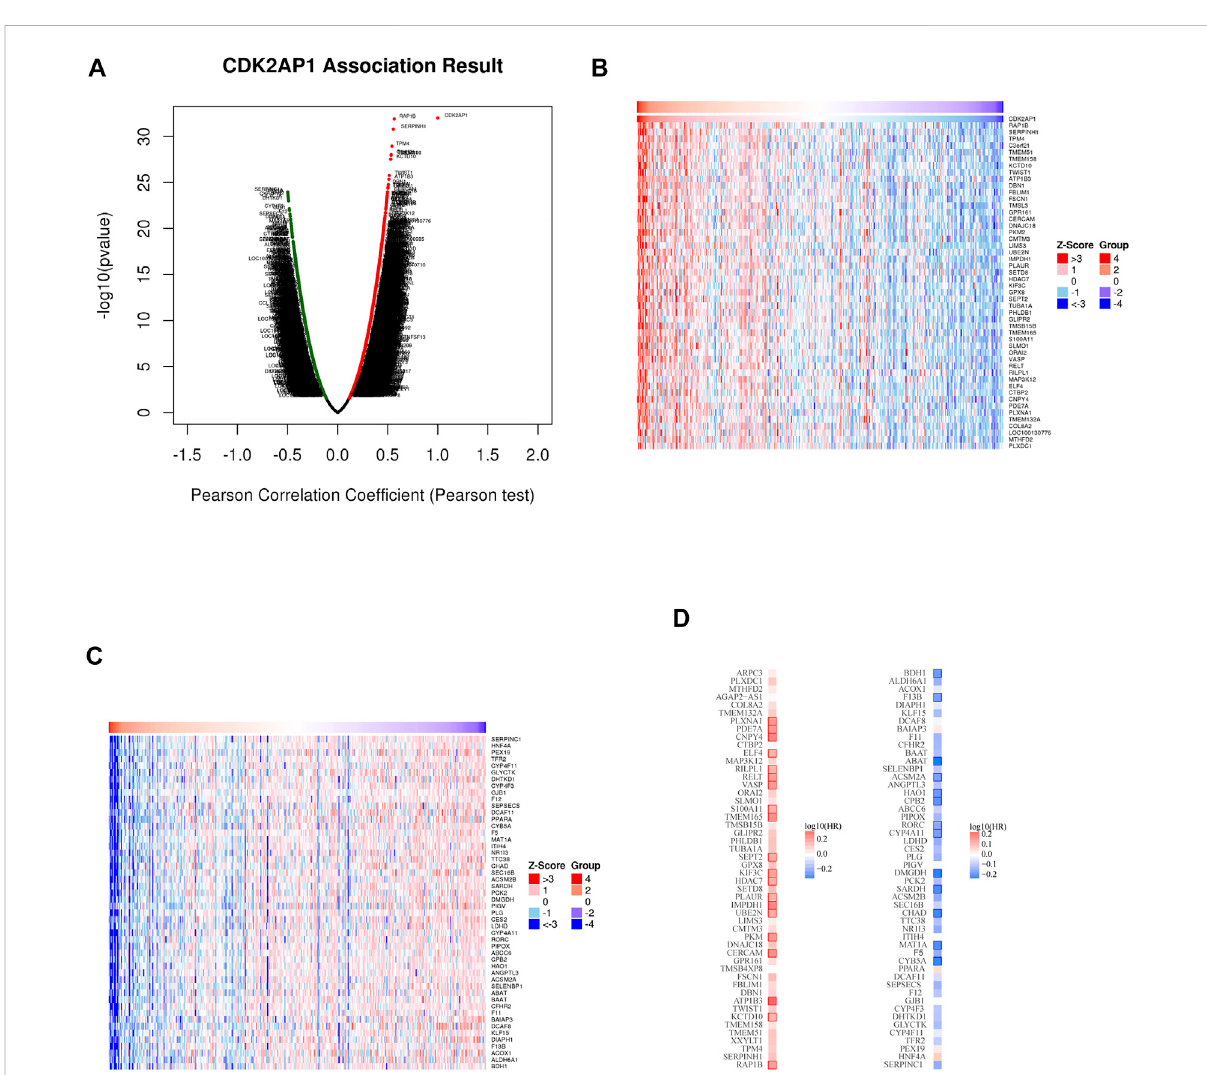
FIGURE 5 The co-expression genes with CDK2AP1 in LIHC (A) Genes signi fi cantly associated with CDK2AP1 were distinguished by Pearson test in LIHC cohort. Red indicates positively related genes and green indicates negatively related genes (B,C) Heatmaps show the top 50 genes positively and negativelyrelatedto CDK2AP1 inLIHC (D) Genesurvivalmapofthetop50genesthatarepositivelyandnegativelyassociatedwith CDK2AP1